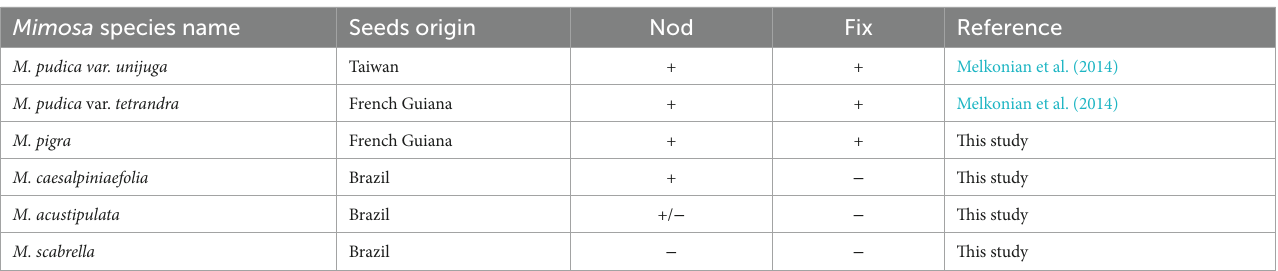
TABLE 2 Symbiotaxonomy of STM6018 using different species of